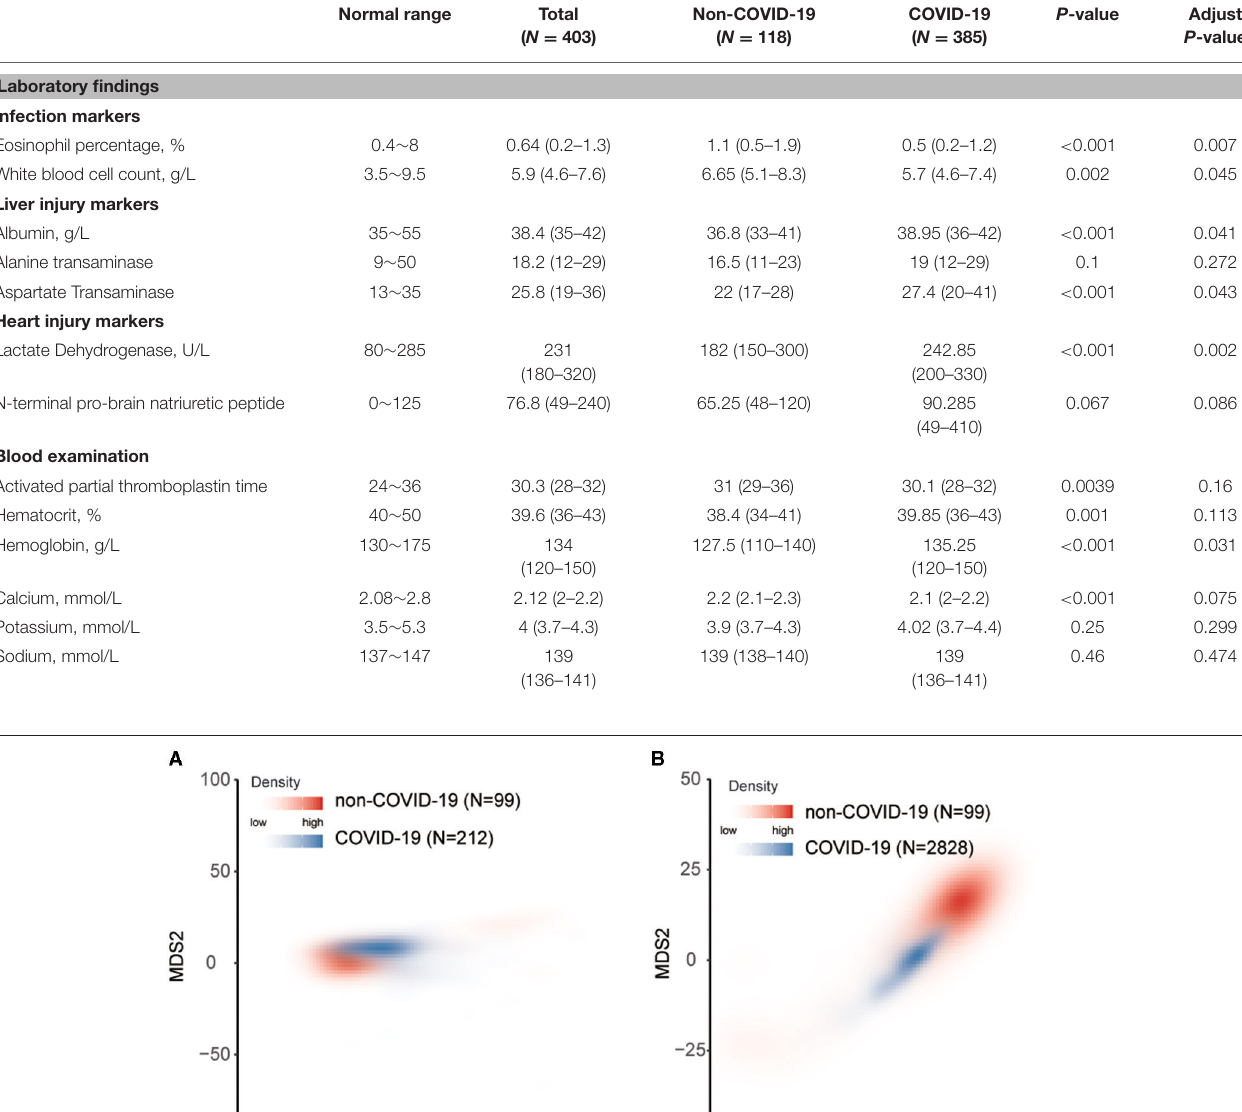
TABLE 2 | Comparing laboratory findings between COVID-19 and non-COVID-19 patients.